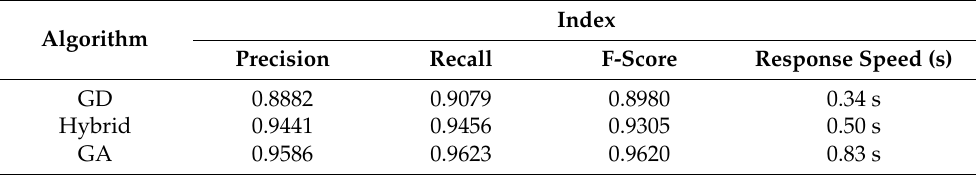
Table 2. Comparison of evaluation index results.